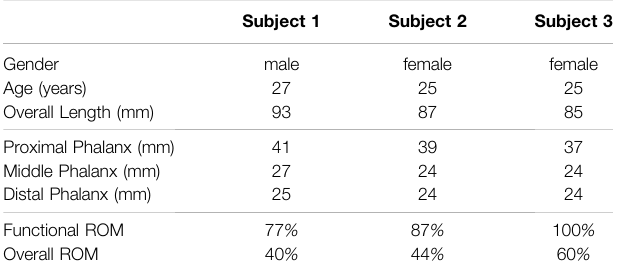
TABLE 1 | Tabulated parameters of the three individual subjects for the index fi nger and the achievable Range of Motion (ROM).